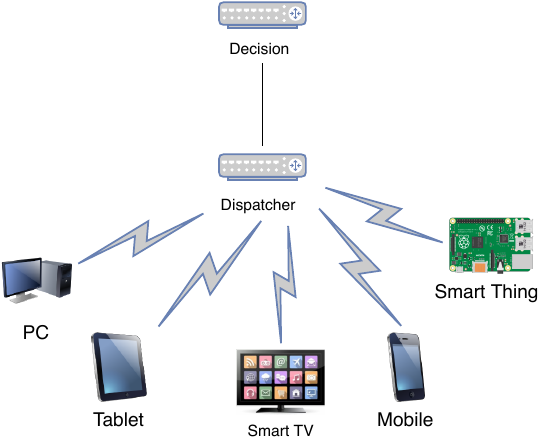
Figure 5. Dispatcher to